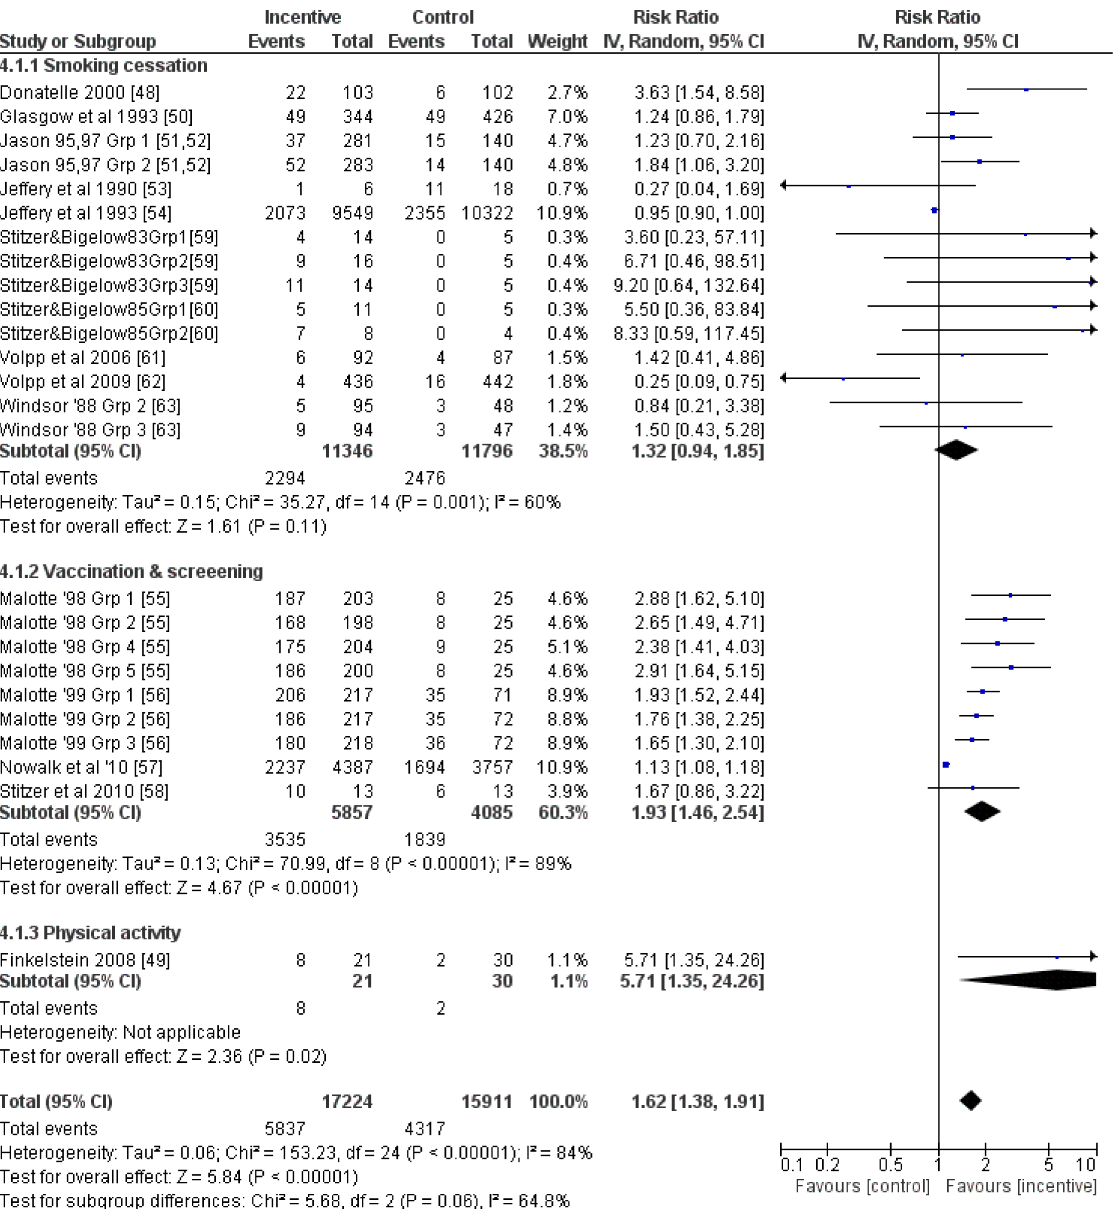
Figure 14. Meta-analysis of financial incentives for all behaviours (latest follow-up point).